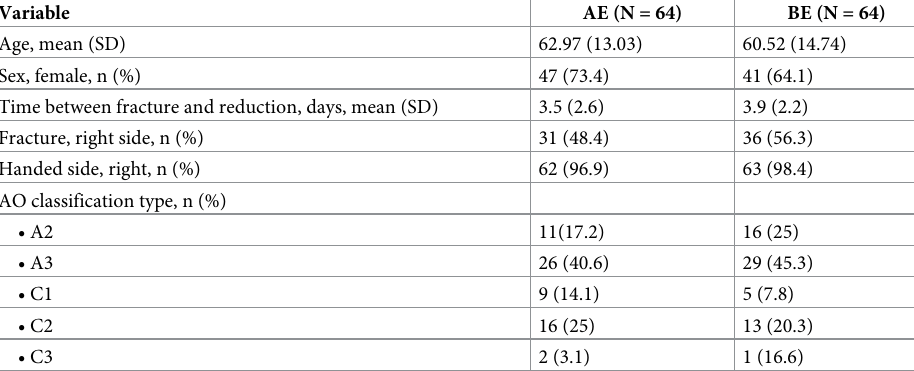
Table 1. Baseline characteristics of patients in the AE and BE groups.